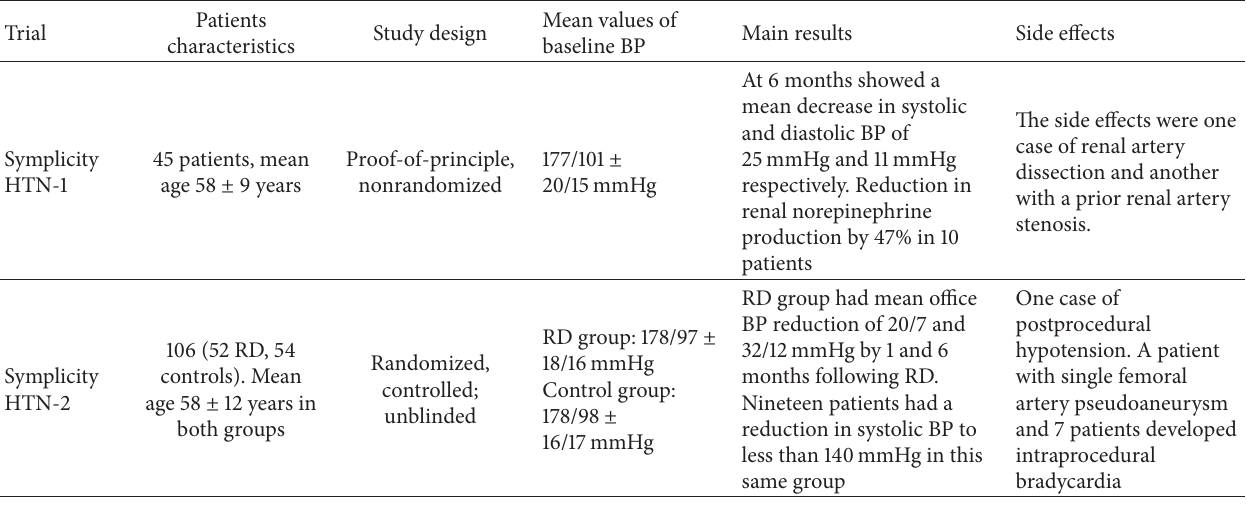
Table 2: Comparison between Symplicity HTN-1 and HTN-2